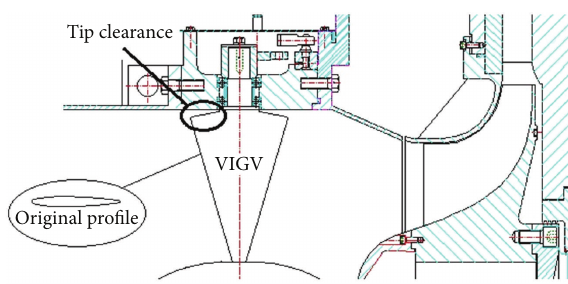
Figure 1: Sketch of VIGV in centrifugal compressor.